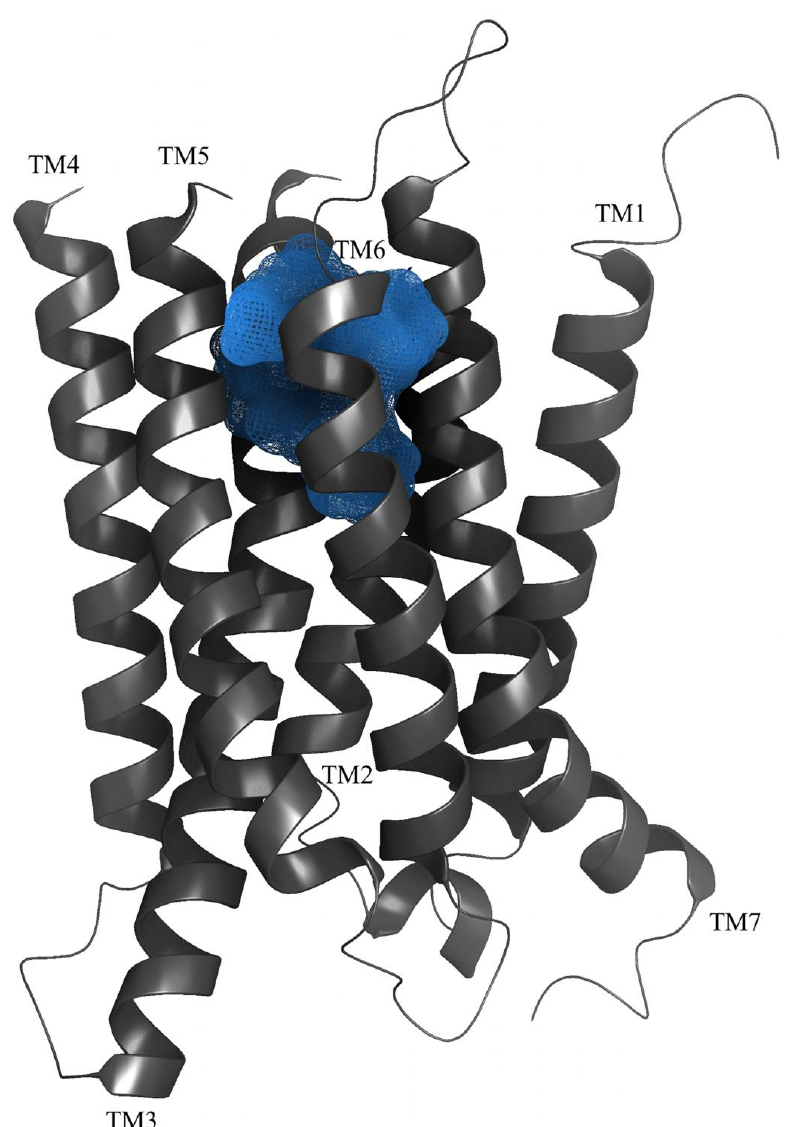
Figure 4. A illustration of the putative allosteric binding pocket (blue sphere) located in GABA B2 (dark grey) surrounded by the seven helices (TM1–TM7) (homology models obtained from Freyd et al. [57]).